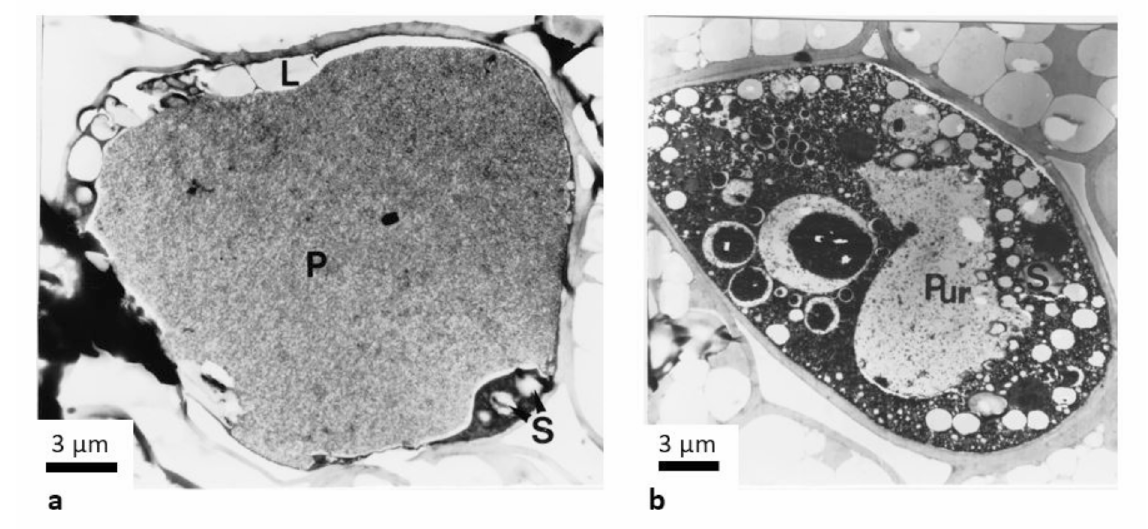
Fig. 7: Polyphenol cells of T. grandiflorum (a) and T. cacao (b) P: polyphenol vacuole, S: starch grain, Pur: purine inclusions Ultra-thin sections